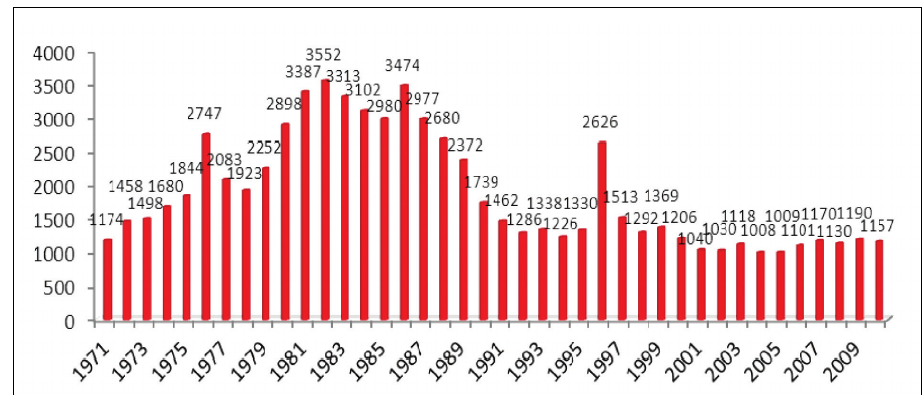
Figure 3. Numbers of runners in the traditional 10K running race called “Běchovice” till